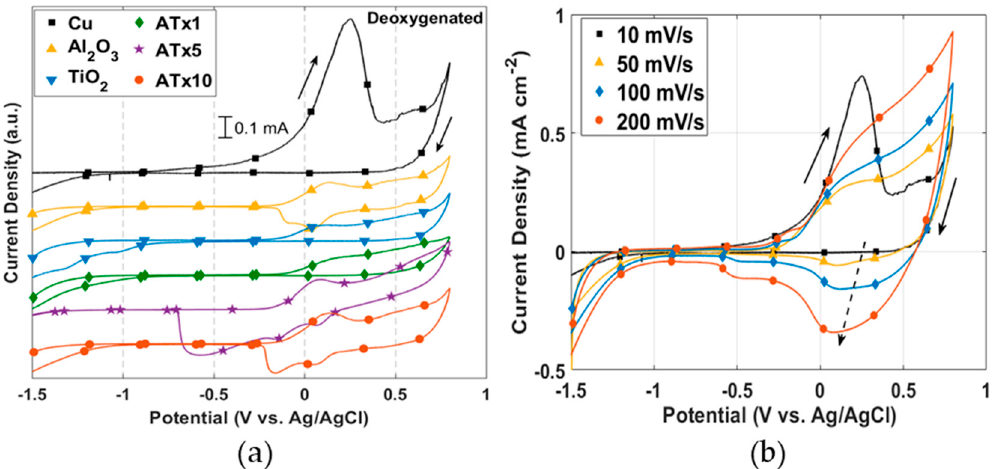
Figure 4. I–V curves in deoxygenated 0.1 M NaCl for: ( a ) uncoated and ALD-coated copper measured at 10 mV/s and ( b ) uncoated copper measured at scan rates from 10 mV/s to 200 mV/s. Solid arrows indicate scan direction and dashed arrow in ( b ) points in the direction of increasing scan rate. Refer to Table 1 for sample descriptions.